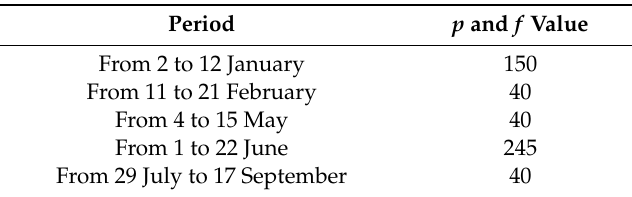
Table 1. p and f